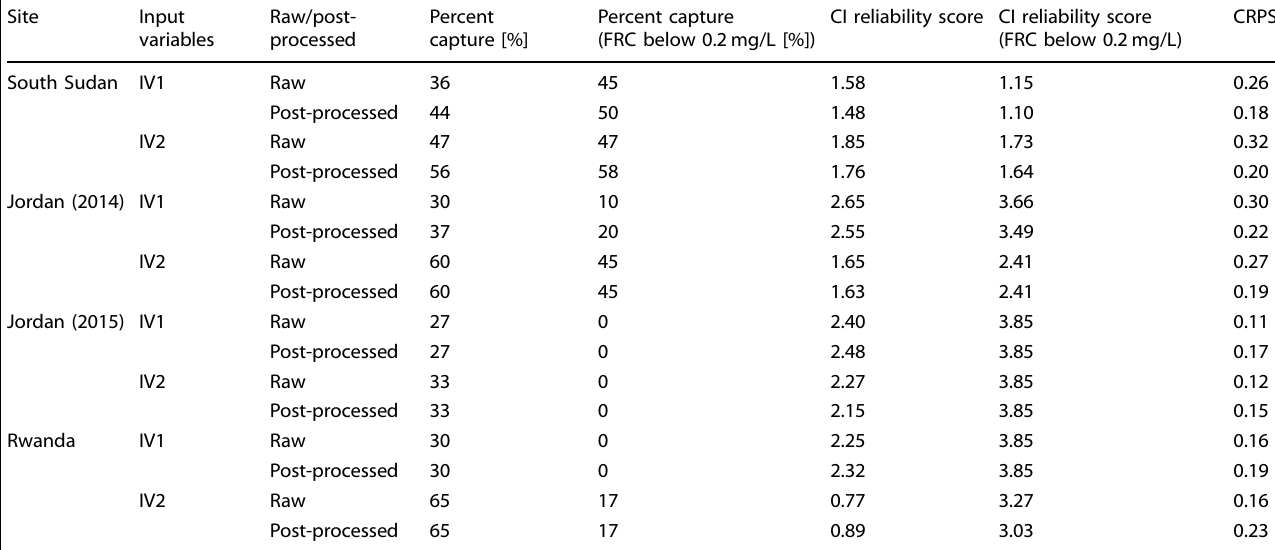
Table 1. Ensemble veri fi cation metrics for all sites and variable combinations for raw and post-processed ensembles.